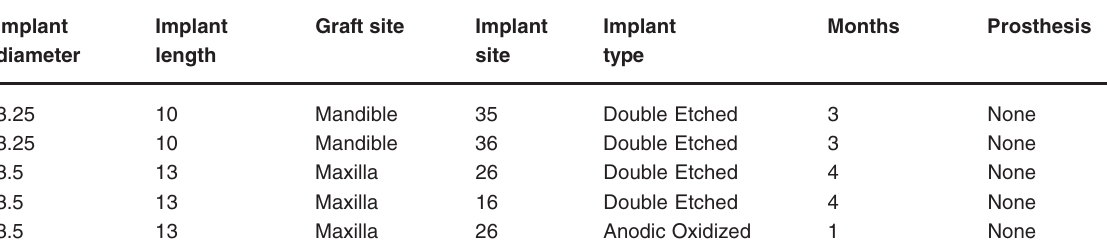
TABLE 2- Failed implants